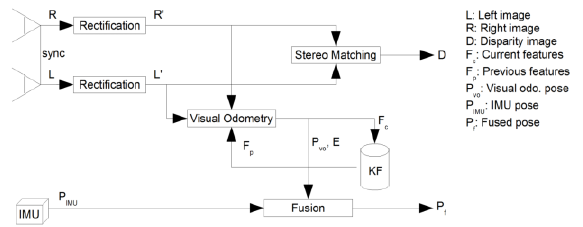
Figure 1. Common work flow of MMS integrated VO add INS (Hirschmüller et al.,